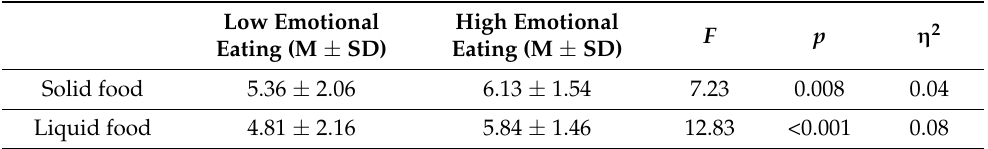
Table 2. Mean scores of eating intention toward solid and liquid foods among patients experiencing negative emotions. Low Emotional High Emotional Eating (M ± SD) Eating (M ± SD) Liquid food